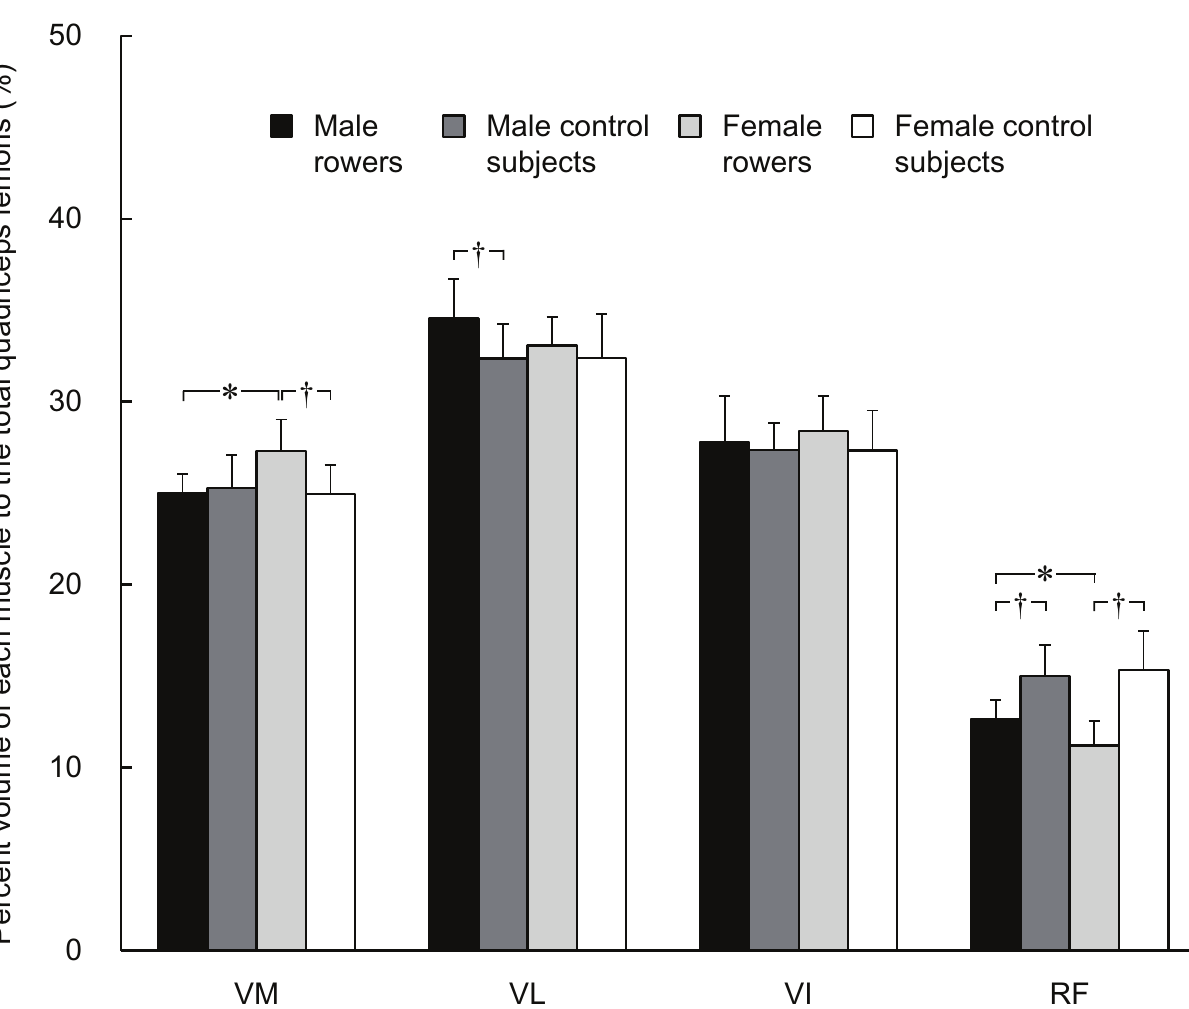
Fig 3. The percent muscle volume of each muscle to the total quadriceps femoris. * indicatesa significantdifference betweenmale and female rowers. † indicatesa significantdifference betweenrowers and control subjectswithin each sex. VM, vastus medialis;VL, vastus lateralis; VI, vastus intermedius; RF, rectus femoris.